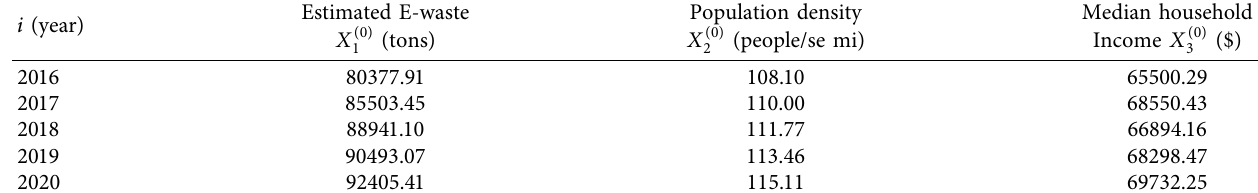
Table 10: Estimated e-waste, population density, and median household income in case three from 2016 to 2020.